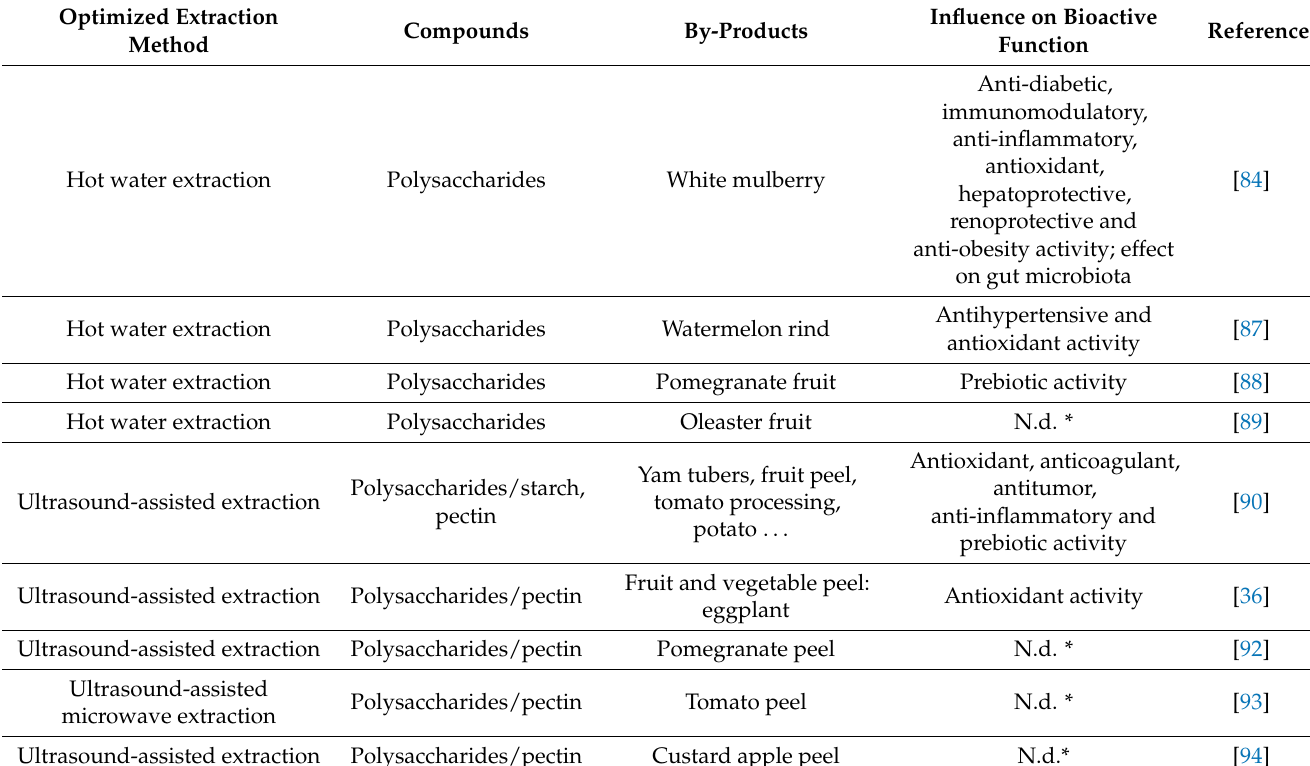
Table 2. Review of optimized extraction methods and their influence on the bioactive function of polysaccharides obtained from plant